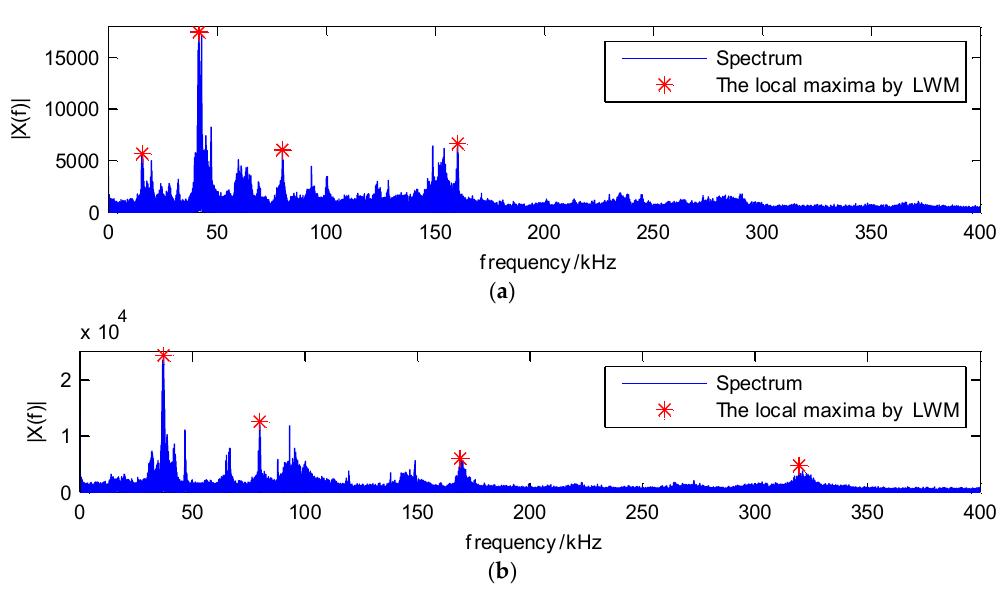
Figure 17. The spectrum and local maxima of ( a ) sensor 1 and ( b ) sensor 2.